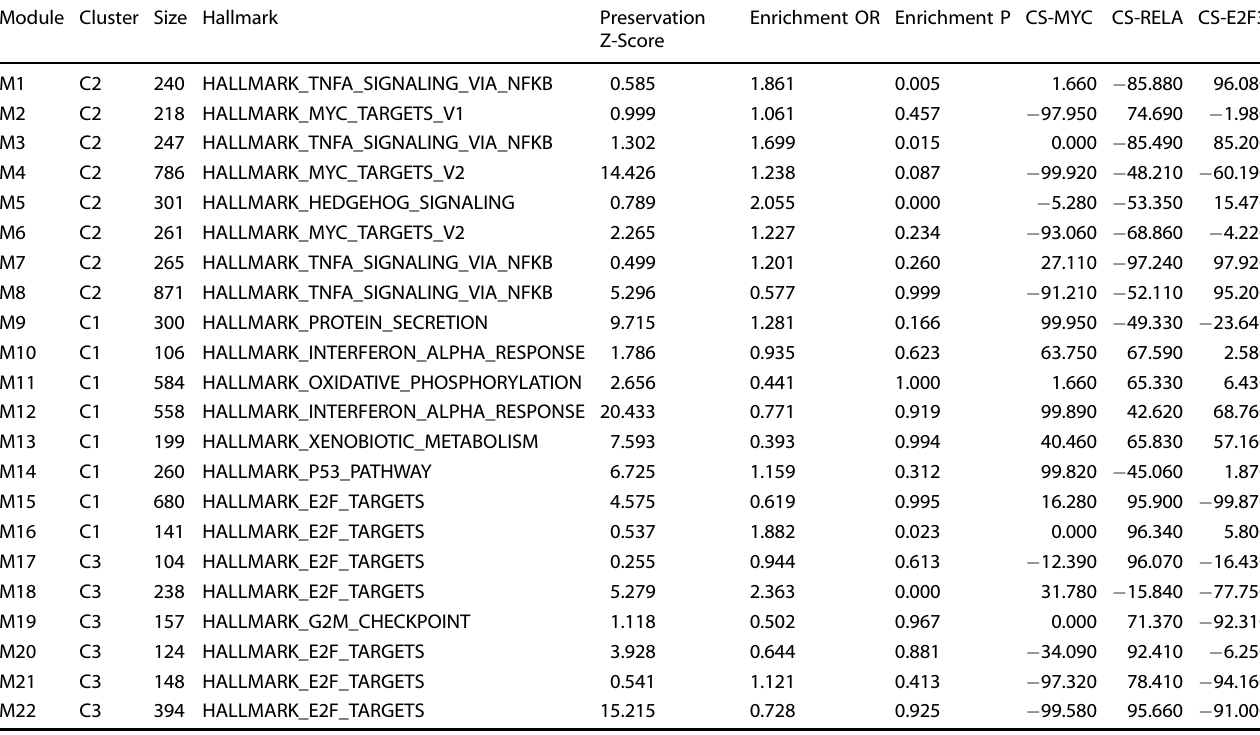
Table 2. Characteristics of co-expression modules. Module Cluster Size